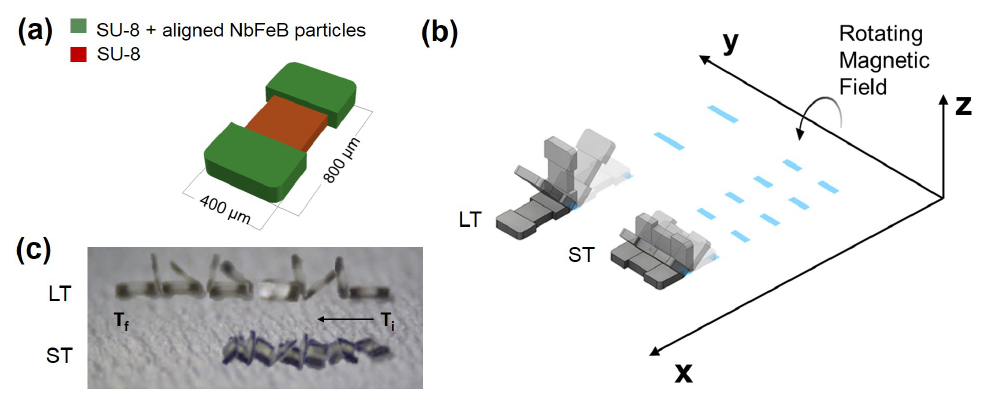
Figure 1. ( a ) Schematic of the microscale magnetic tumbling ( µ TUM) robot. The rectangular-shaped microrobot has embedded magnetic particles at each end. ( b ) Depending on the alignment of the magnetic particles, a rotating magnetic field will cause the µ TUM to either lengthwise tumble (LT) or sideways tumble (ST). ( c ) Screen-shots from Supplemental Video S1 demonstrating both types of tumbling